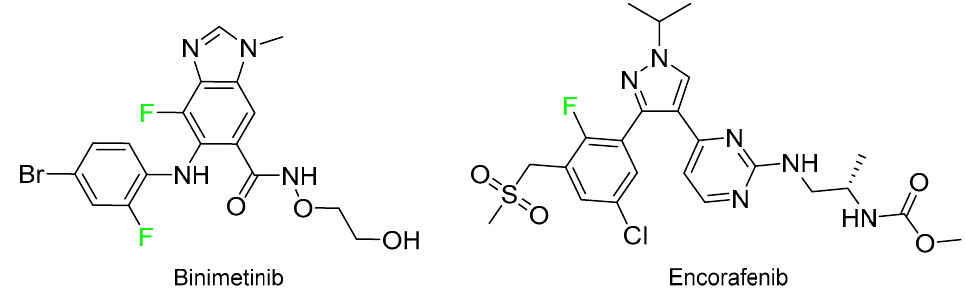
Figure 15. Structure of drugs for BRAF-mutated melanoma.